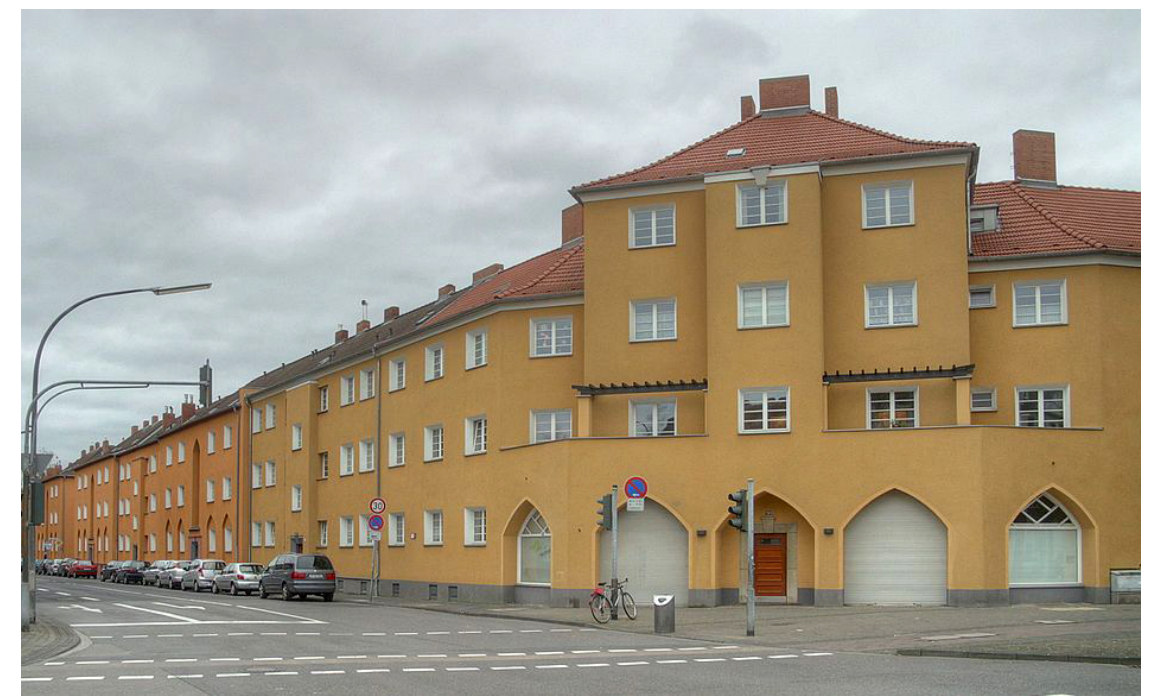
Figure 12. W. Riphahn and C. M. Grod, Rosenhof-Siedlung , Akazienweg-Venloer Straße, Cologne. Source: Joauth (2012). wells protruding slightly from the façade, with giving a pleasantly rhythmic effect to the façade on the road front. The buildings rose three to four floors at most, with cuts of housing based on four basic building types, which combined to develop eleven possible variants: the east and south to get the maximum